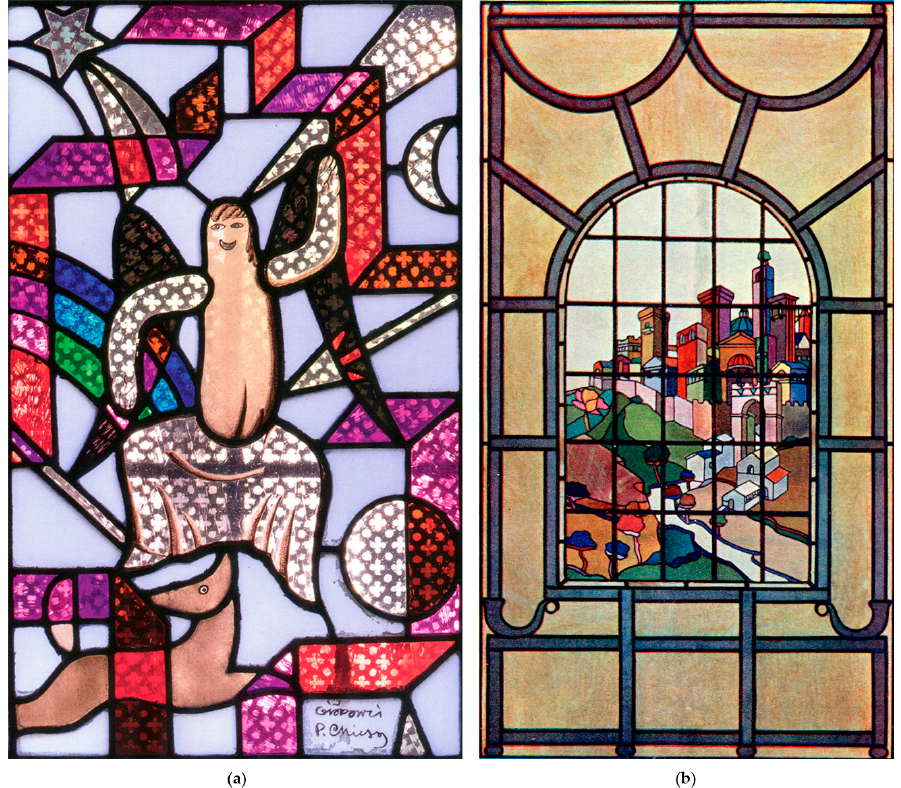
Figure 1. ( a ) Pietro Chiesa (execution), composition by Pietro Chiesa and Gio Ponti, Vetrata allegorica